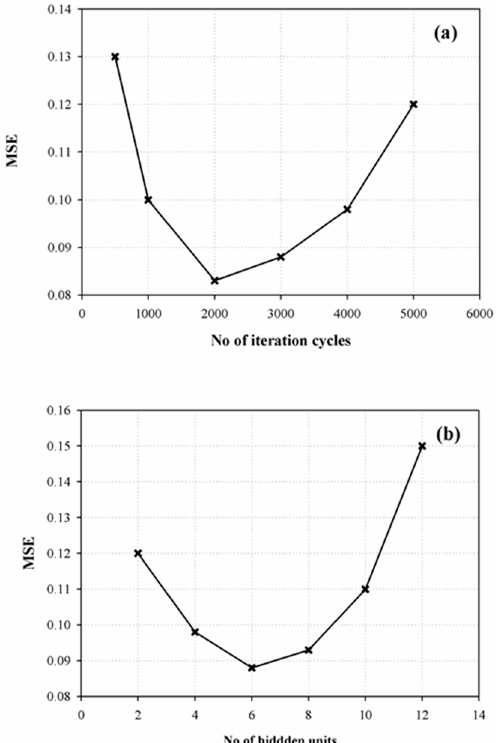
Figure 7. Determination of optimum training cycles ( a ) and number of hidden units ( b ) during ANN development.